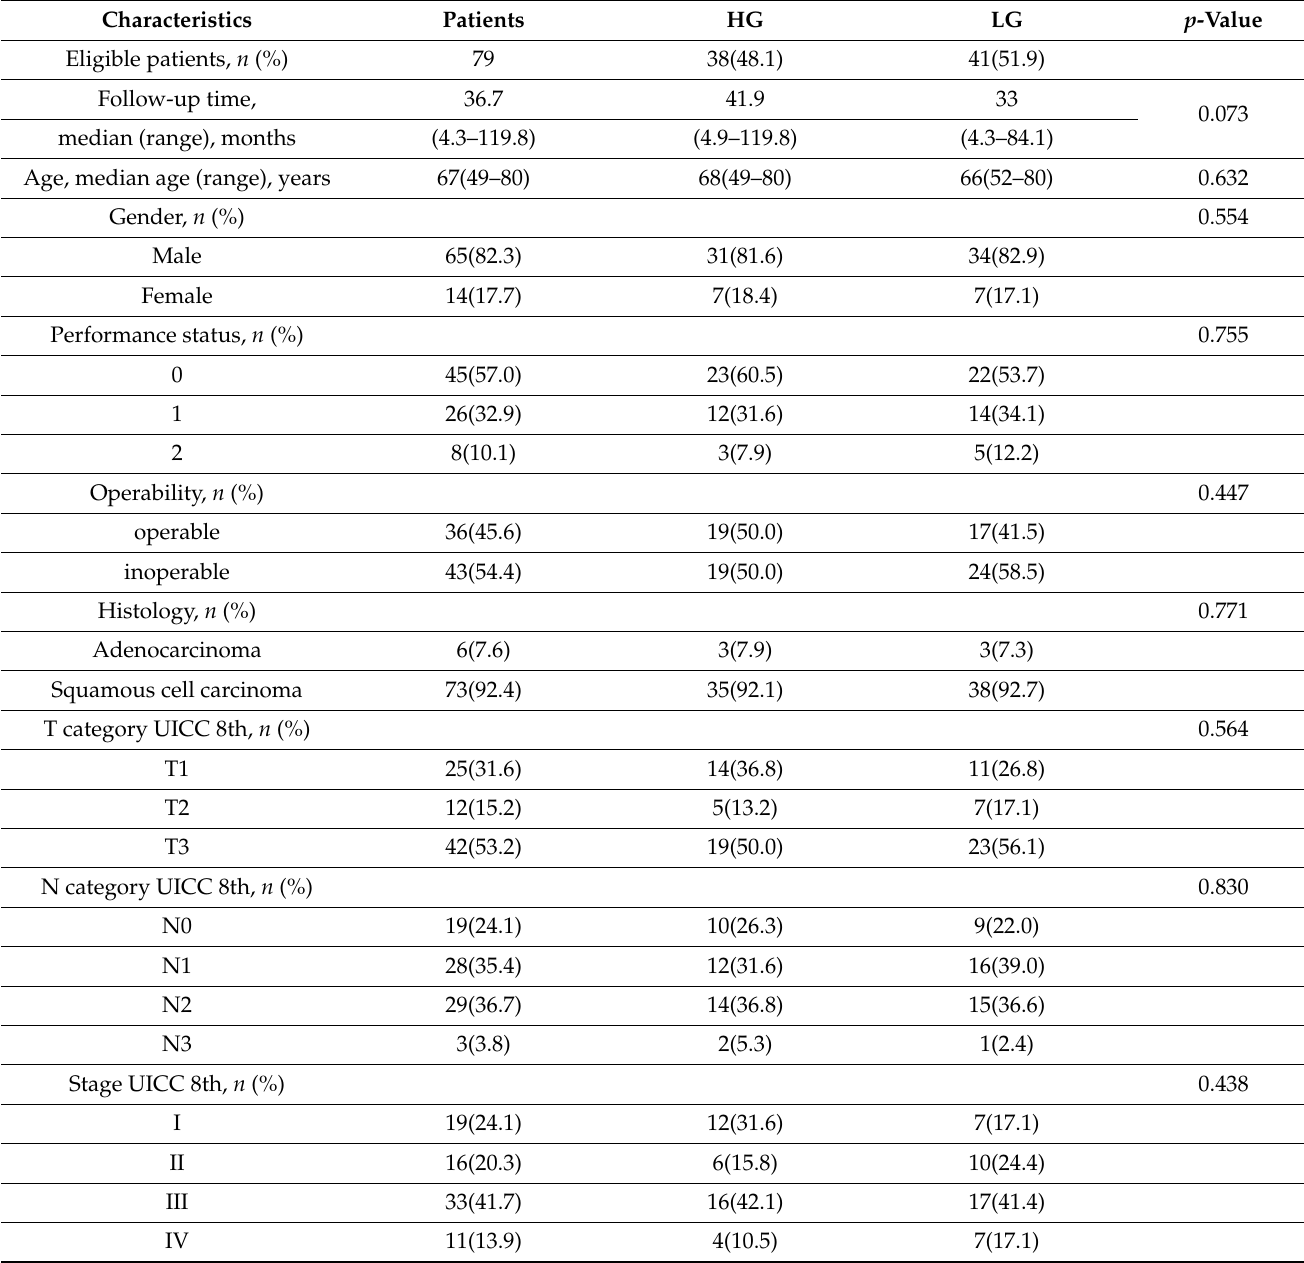
Table 1. Patient